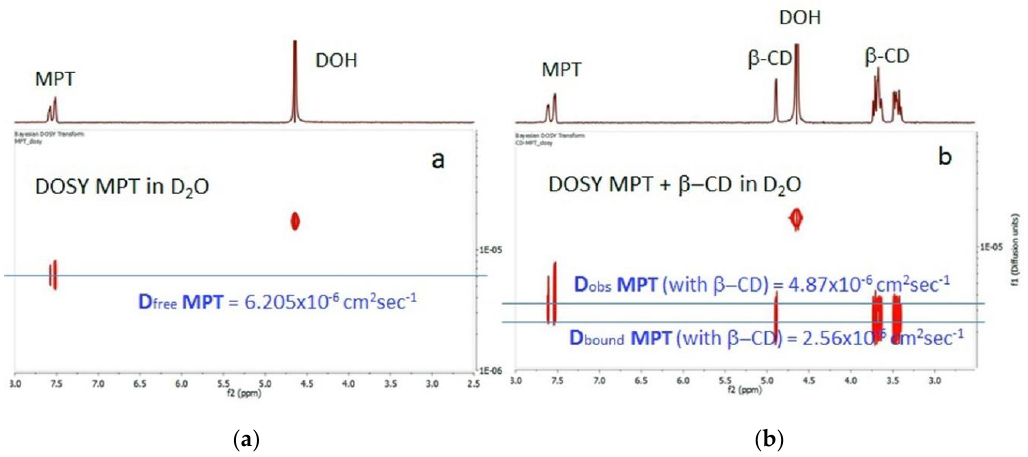
Figure 5. Pseudo 2D DOSY spectra of MPT ( a ) 1.5 mM; ( b ) in the presence of β-CD 1.4 mM in D 2 O, at 23 °C. (See Supplementary Information, SI, for details). Table 2. Diffusion coefficients ( D , 10 −6 cm 2 ·s −1 ) related to the itemized protons of MPT free (MPT alone 1.5 mM), MPT ( + β -CD) (MPT 1.5 mM with β -CD 1.4 mM), and β -CD ( + MPT) (MPT 1.5 mM with β -CD 1.4 mM), fraction of complexed MPT and β -CD molecules ( p ) and association constant for